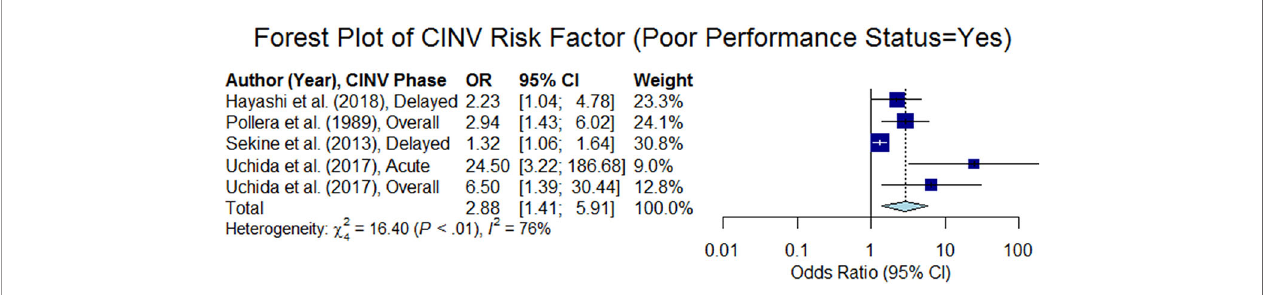
FIGURE 11 | Forest plot of Chemotherapy-Induced Nausea and Vomiting (CINV) risk factor (poor performance status